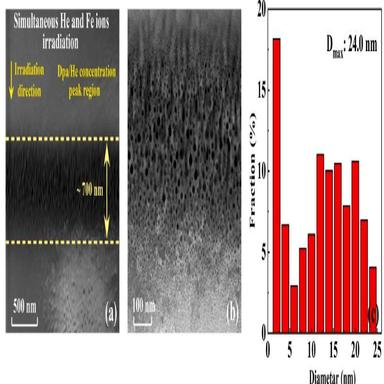
Cross-sectional TEM images of Dpa/He concentration peak region at different magnifications for Cu sample irradiated by simultaneous Fe and He ions irradiation.